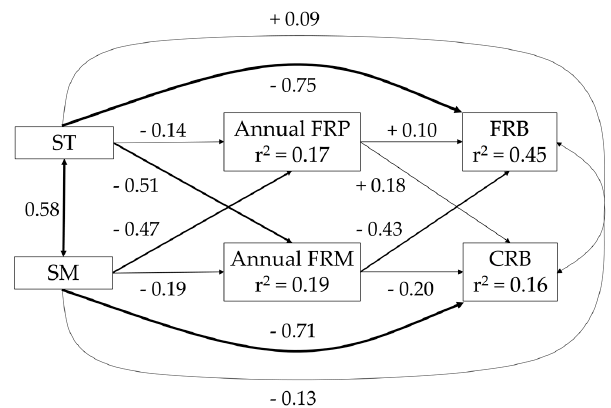
Figure 3. Causal models developed using path analysis for soil temperature (ST) and soil moisture (SM) effects on annual fine root production (FRP), annual fine root mortality (FRM), fine root biomass (FRB), and coarse root biomass (CRB) of Pinus densiflora seedlings. Numbers on arrows represent standardized path coefficients (the width of arrows is proportional to the absolute value of each coefficient).